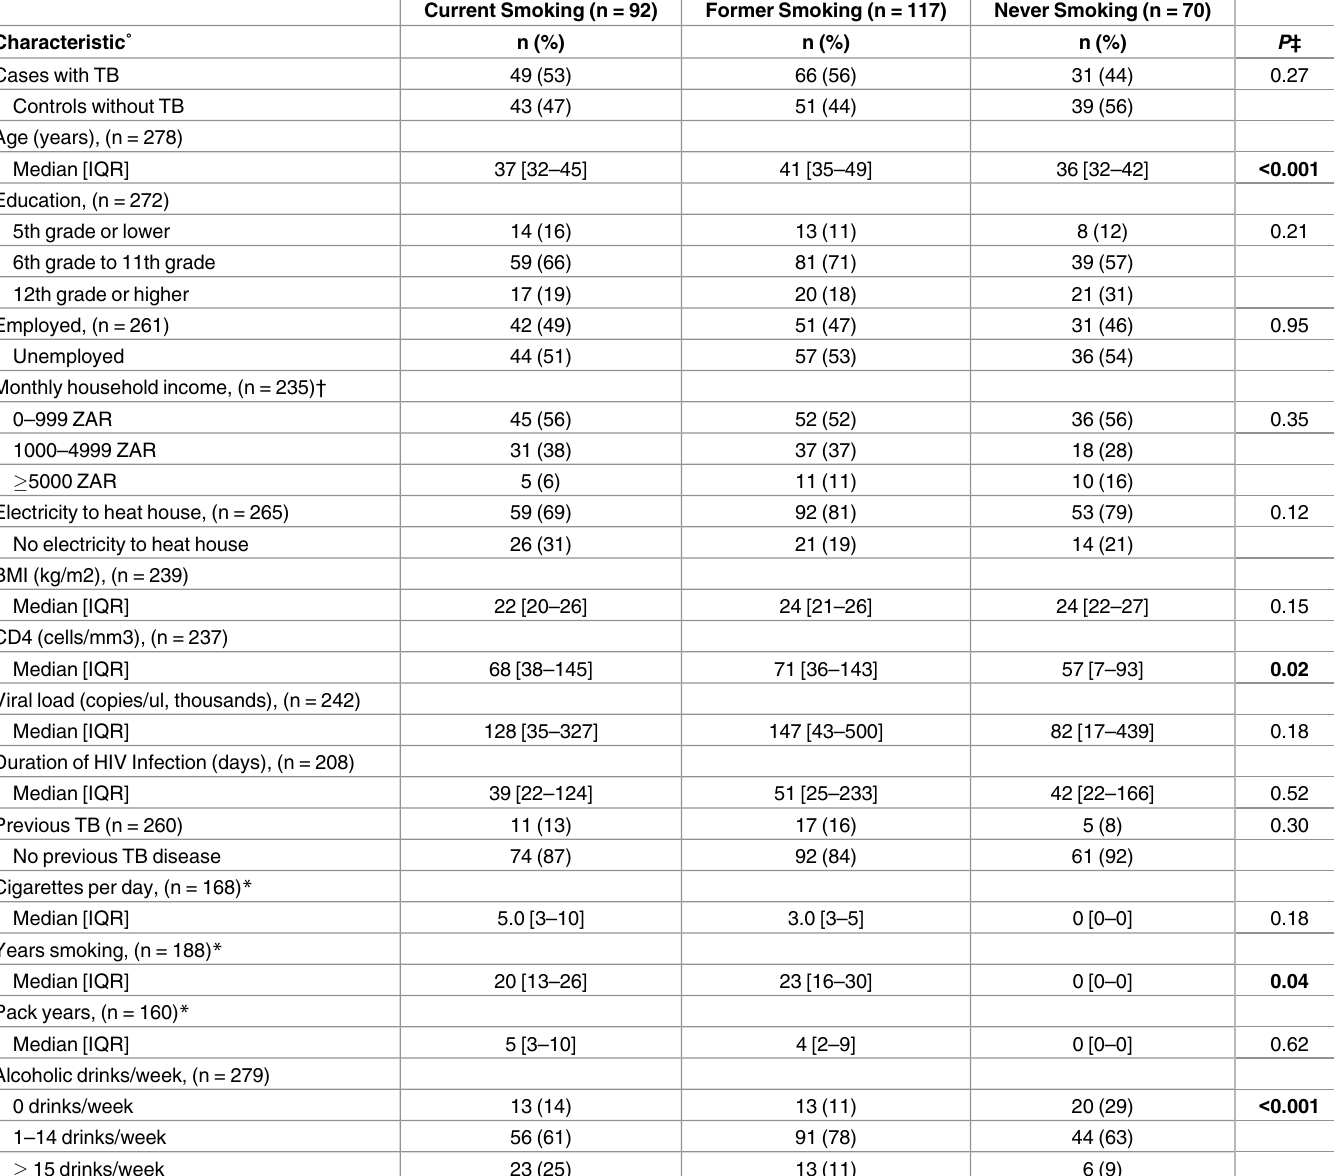
Table 2. Socio-demographic characteristics according to smoking history among men with HIV in Soweto, Johannesburg, South Africa (n =